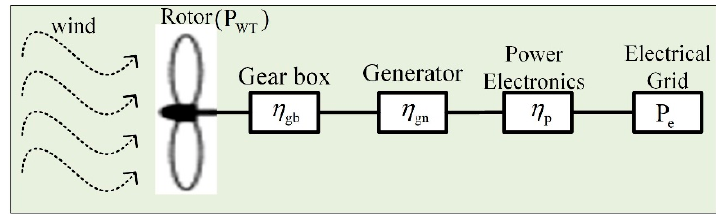
Figure 4. Energy transfer from wind to electrical grid.